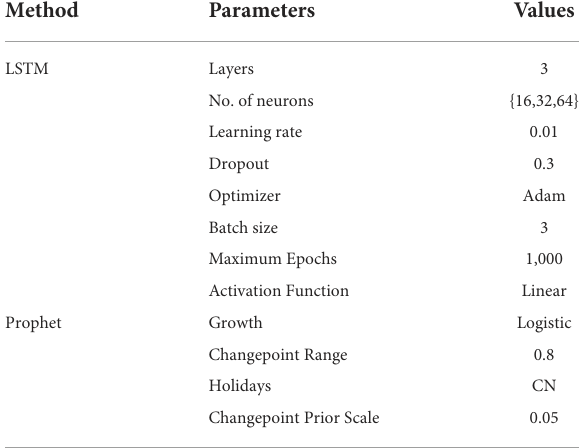
residuals of the model SARIMA (1,1,0), (2,1,3) 12 models are TABLE 2 Prophet and LSTM parameters and their